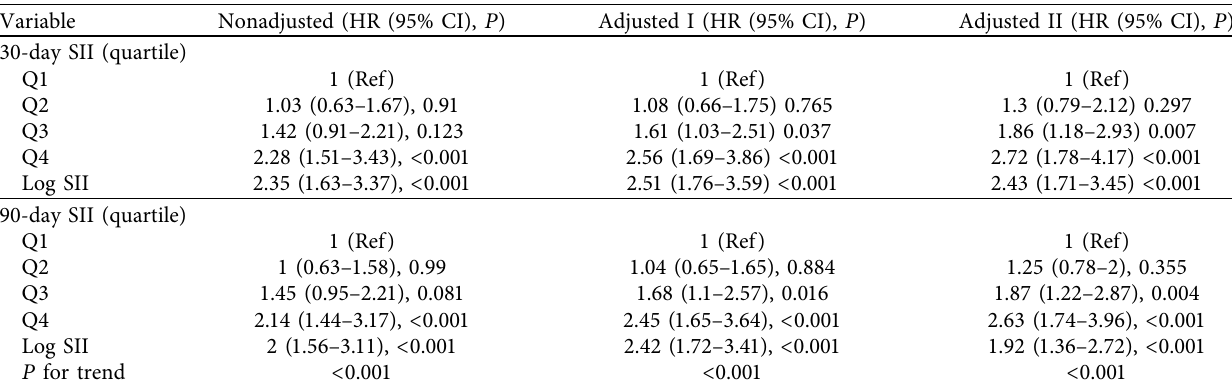
Table 3: Multivariate Cox regression analysis between quartiles of the systemic immune-inflammation index and 30-day mortality.